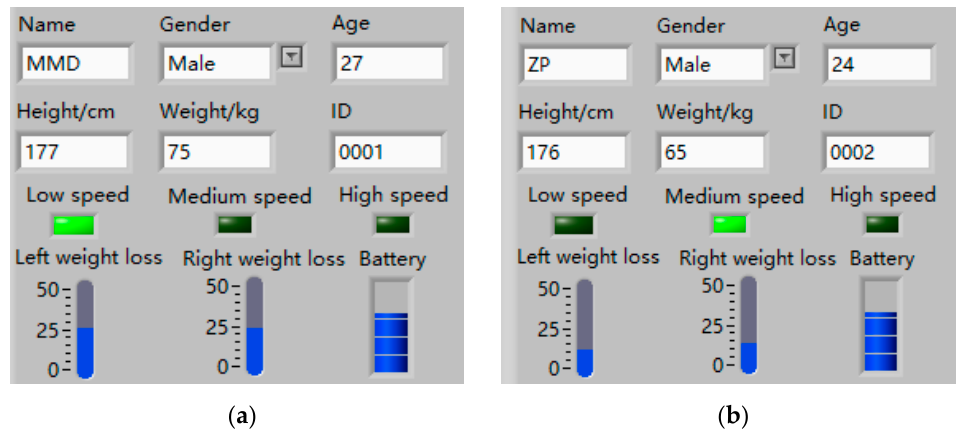
Figure 13. ( a ) Logic 1 state of the robot; ( b ) logic 2 state of the robot.